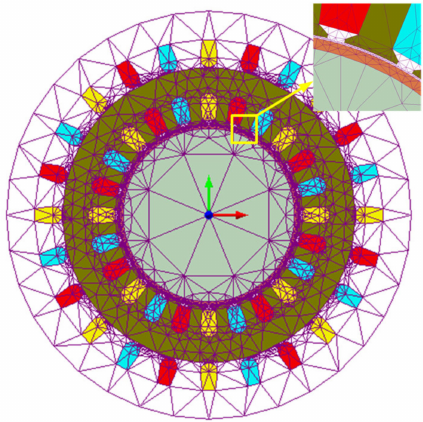
Figure 11. Finite element model of copper-plated solid rotor induction motor.